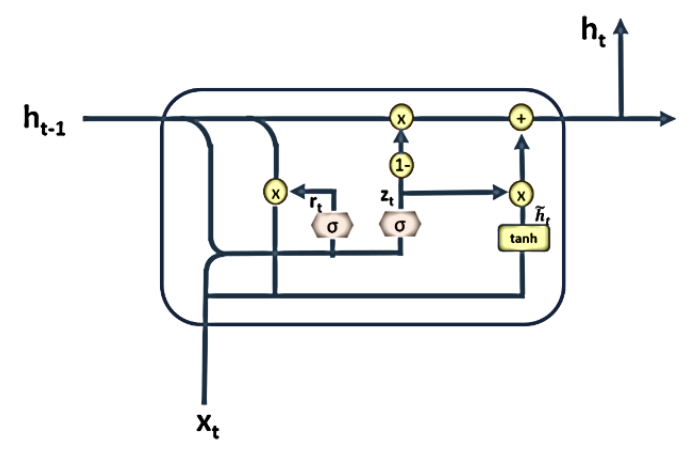
Figure 4. The basic gated recurrent unit (GRU).